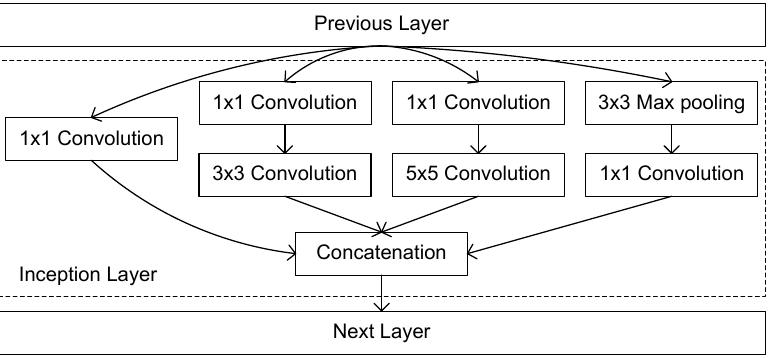
Figure 4. Inception block of